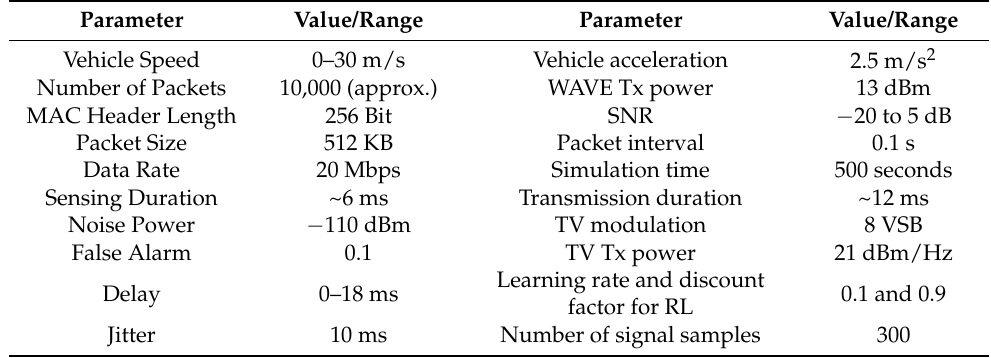
Table 4. Simulation and parameters settings.